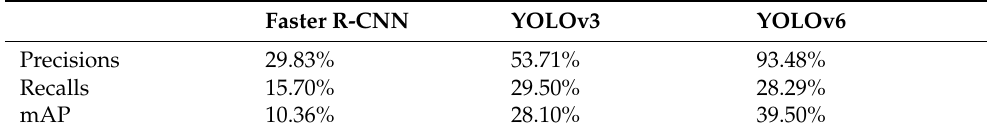
Table 6. Comparison of the proposed model with YOLOV3 and Faster R-CNN only on a small target firing dataset in regards to accuracy, recall, and mAP (mean Average